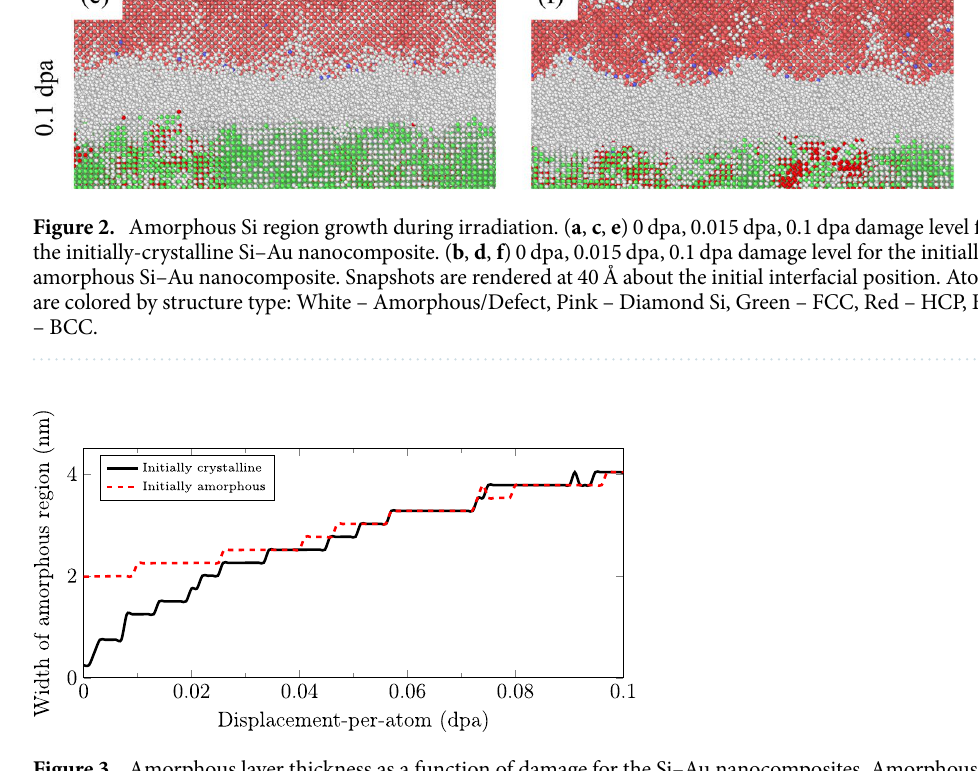
Figure 3. Amorphous layer thickness as a function of damage for the Si–Au nanocomposites. Amorphous region is defined such that more than half of local atoms are identified as